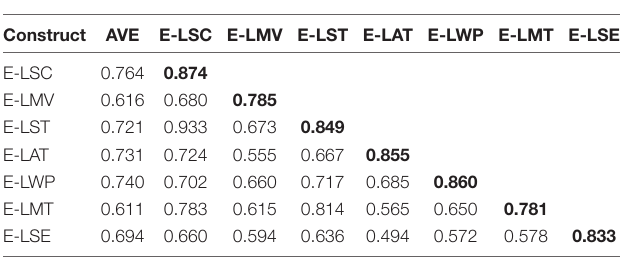
TABLE 3 | Discriminant validity.